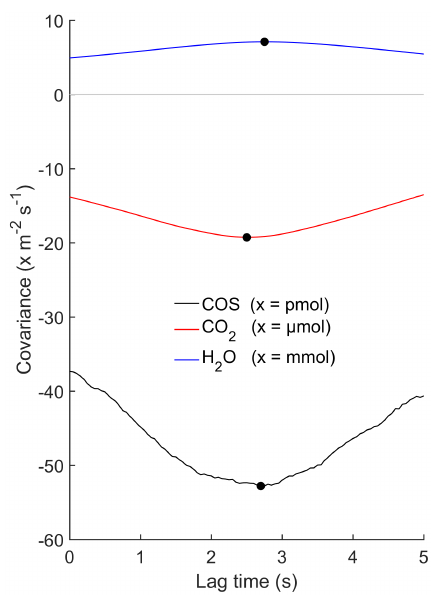
Figure 1. The covariance of vertical wind speed with the COS (black line), CO 2 (red line) and H 2 O (blue line) molar density as a function of the (mostly) tube-induced time delay. Lag times in this example were COS = 2.6s, CO 2 = 2.5s, H 2 O = 2.85s. Data corre- spond to 5 July 2015 10:00–10:30CET (Central European